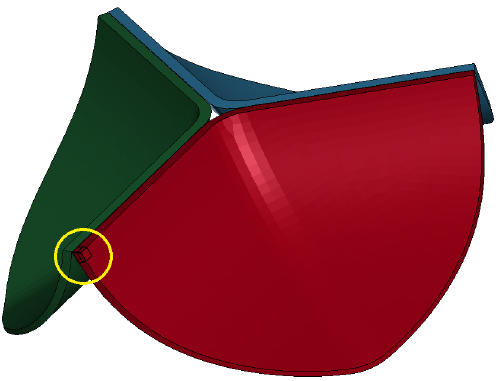
Figure 6. The location of commissure point of the 3D model of asymmetry tri-leaflet.